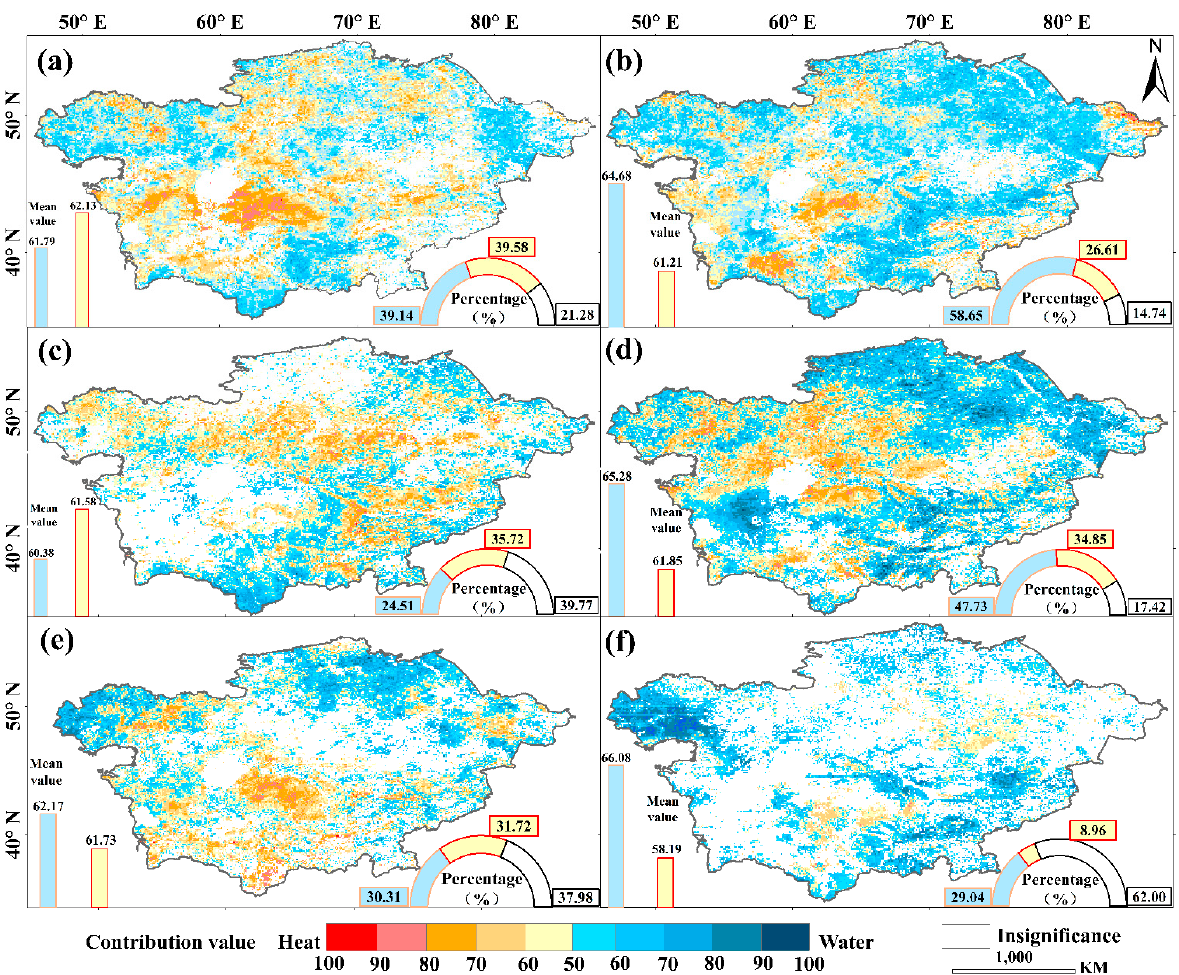
Figure 6. The contributions of hydrothermal conditions to vegetation changes at the annual ( a ) and growing season ( b ) scales, and in spring ( c ), summer ( d ), autumn ( e ), and winter ( f ); the pie chart represents the proportion of heat conditions values and water conditions values ≥ 50%; the Mean value represents the average contribution of heat and water conditions in the areas with heat or water contribution value ≥ 50%.